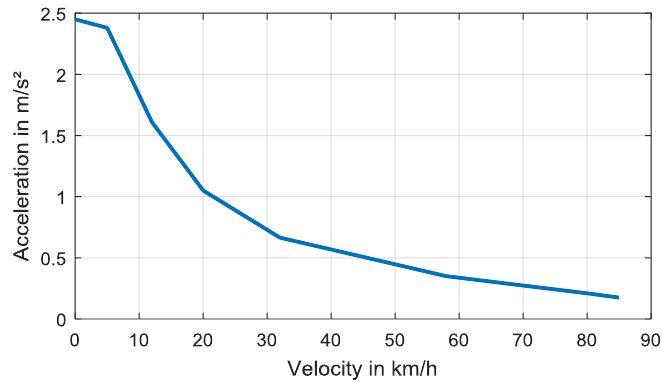
Figure 4. The set acceleration for the semi-trailer truck depending on the actual velocity.